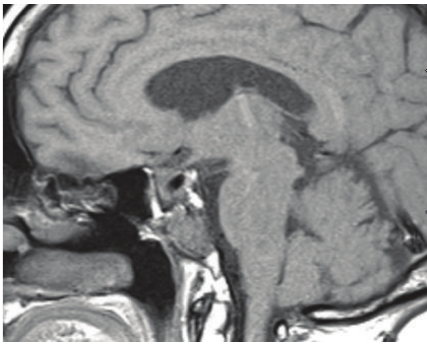
Figure 2: Sagittal image on clinical recurrence showing tumor invasion of the clivus.